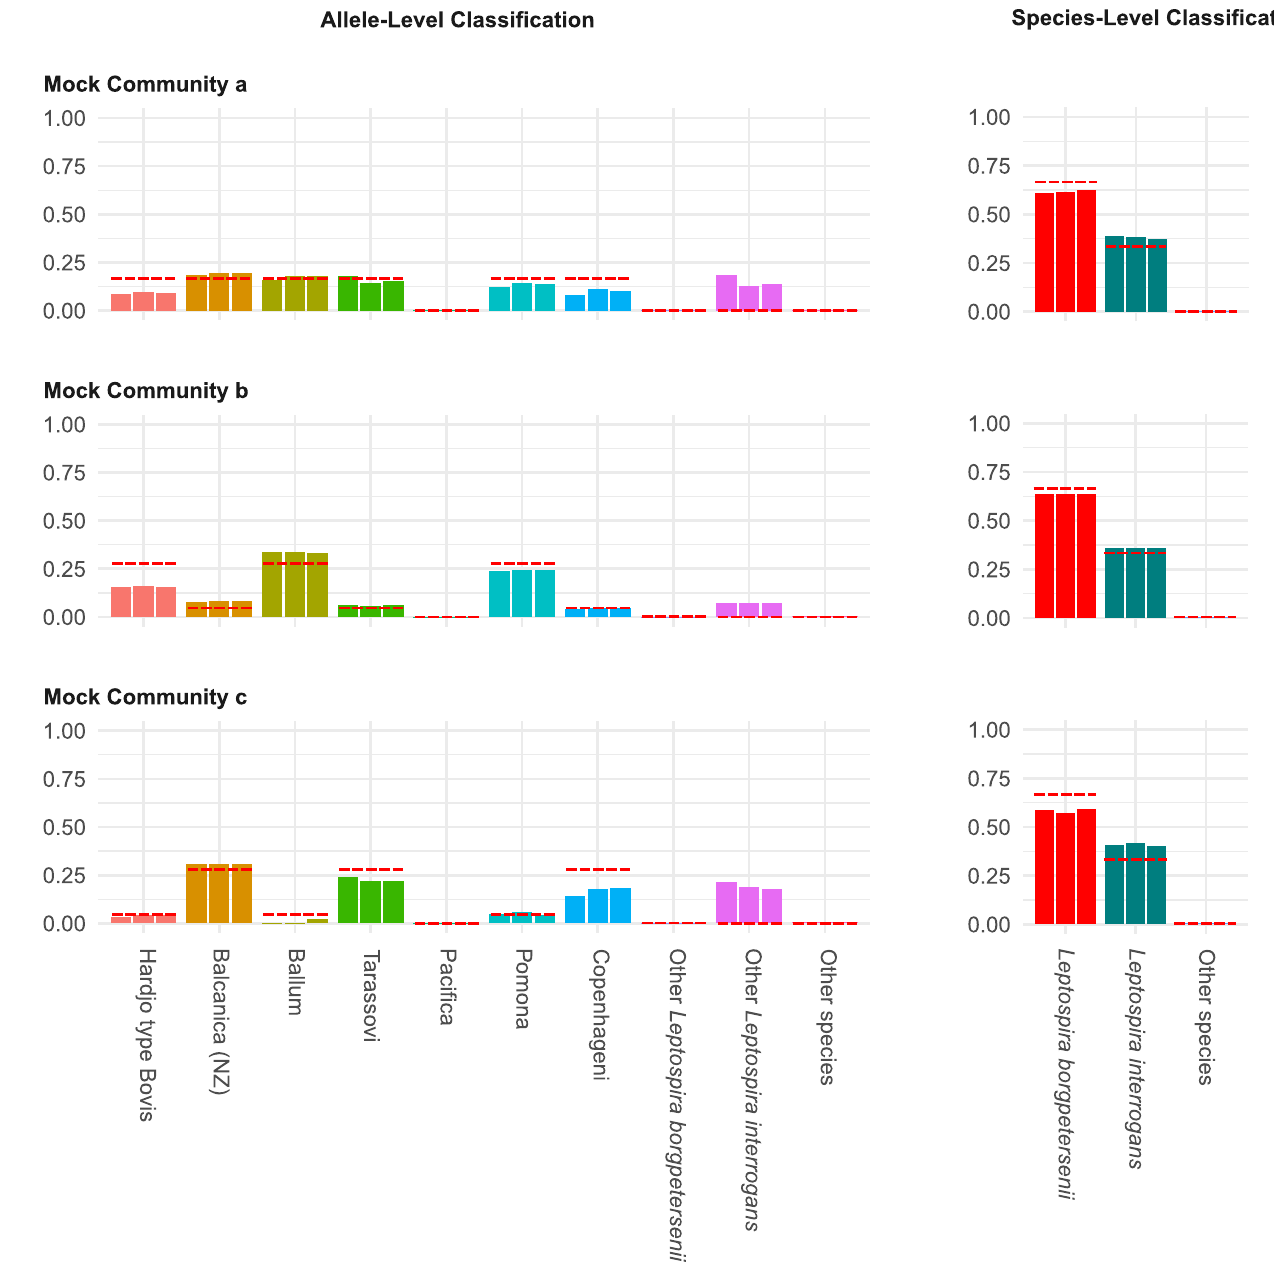
Fig 4. Leptospira variant identification using metabarcoded primers amplifying the glmU locus from three mock community samples using Oxford Nanopore sequencing. Mock community “a” contains a DNA ratio of 1:1 for all serovars, mock community “b” contains a DNA ratio of 5:1 for Hardjo type Bovis, Ballum, Pomona: Balcanica (NZ), Tarassovi, Copenhageni and, mock community “c” contains a DNA ratio of 1:5 for Hardjo type Bovis, Ballum, Pomona: Balcanica (NZ), Tarassovi, Copenhageni. Red dashed lines on each taxon represent the expected proportion of sequences based on the composition of each mock community. Each experiment was performed in triplicate using independently mixed mock communities each